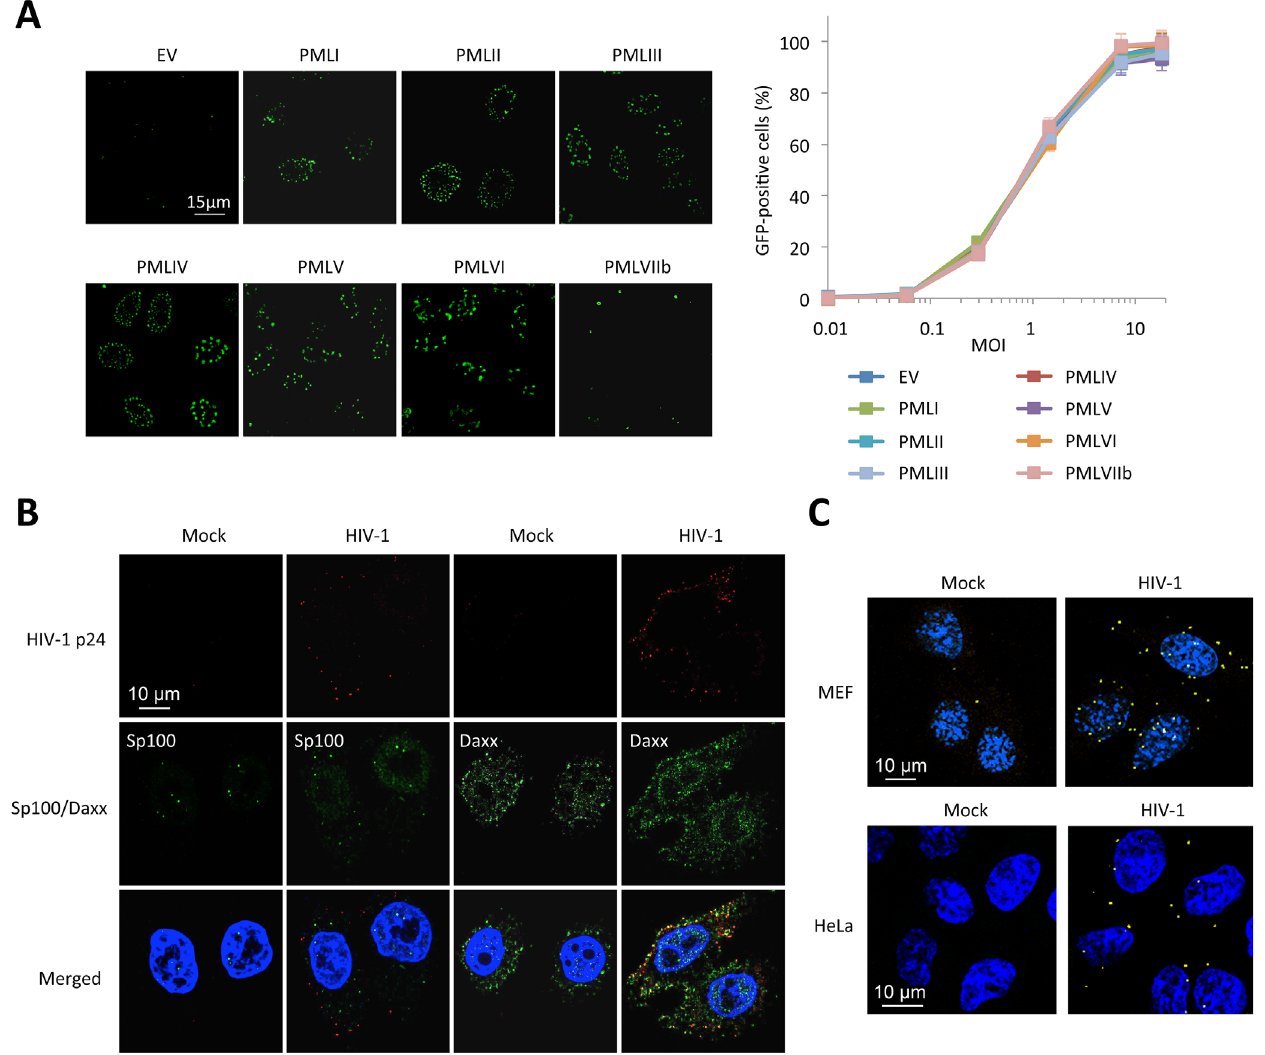
Fig 5. PML is not the main mediator of HIV-1 restriction. (A) PML KO MEFs were transduced with HIV-1 derived lentiviral vectors expressing each human PML isoform (PMLI to PMLVIIb) or with an empty vector (EV). PML isoform expression was evaluated by immunofluorescence. Two days post-transduction, PML expressing cells were transduced with GFP-expressing HIV-1 vector and the percentage of GFP-expressing cells was evaluated by flow cytometry. Graph shows means of triplicate values +/- SD, representative of two independent experiments. (B) Wt HeLa cells were transduced for 2 h with HIV-1 vector and HIV-1 p24 (in red), Sp100 and Daxx (in green) localization was analyzed by immunofluorescence. (C) Wt MEFs or HeLa cells were left untransduced or transduced with HIV-1 for 2 h and probed with anti-Daxx and anti-HIV-1 p24 antibodies. Representative images of a Duolink experiment are shown.